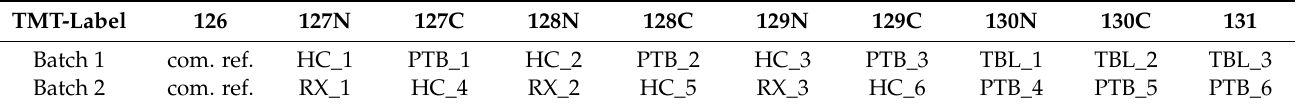
Table 1. Scheme of tandem mass tag-labeled (TMT) batches. Eighteen samples were labeled with tandem mass tags 10-plex kit (columns, 126–131) and combined into two batches (rows), both including a common reference (com. ref.) for inter-batch correction. HC—healthy control, PTB—pulmonary tuberculosis, TBL—tuberculous lymphadenitis, Rx—PTB after anti-tuberculosis treatment. Numbers behind sample group annotations indicate replicate